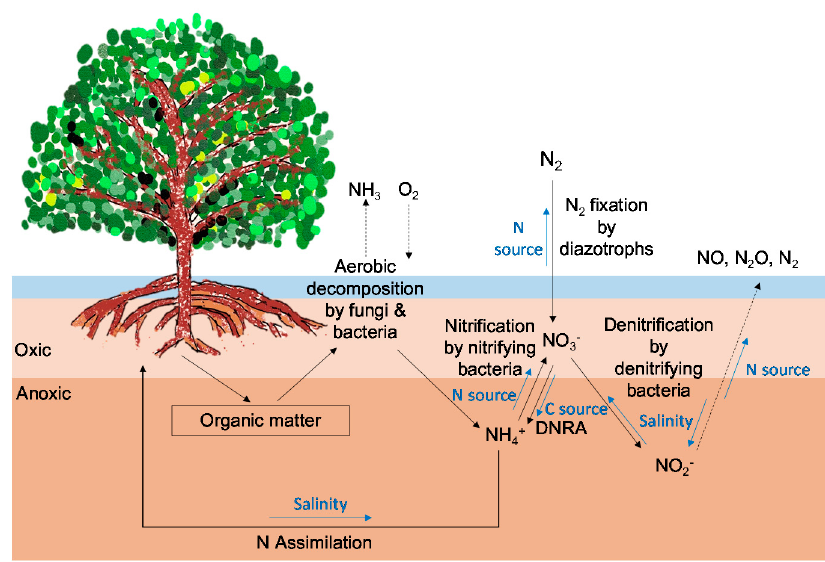
Figure 2. Potential pathways for the N cycle in mangrove forests (modified from Vepraskas and Craft [63]). The black arrows indicate the N pathways. The blue arrows indicate the direction in which increases in environmental factors (salinity, C source, N source) may affect the N pathways.